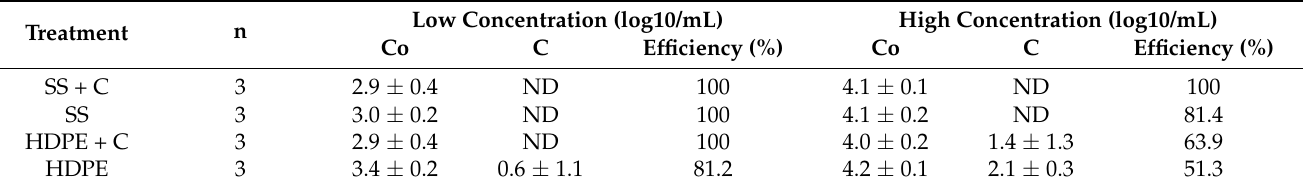
Table 4. Disinfection efficiency of coated (SS + C, HDPE + C) and non-coated materials (SS, HDPE) exposed to UV-A LED light for two initial concentrations: a low concentration (10 3 CFU/mL) and a high concentration (10 4